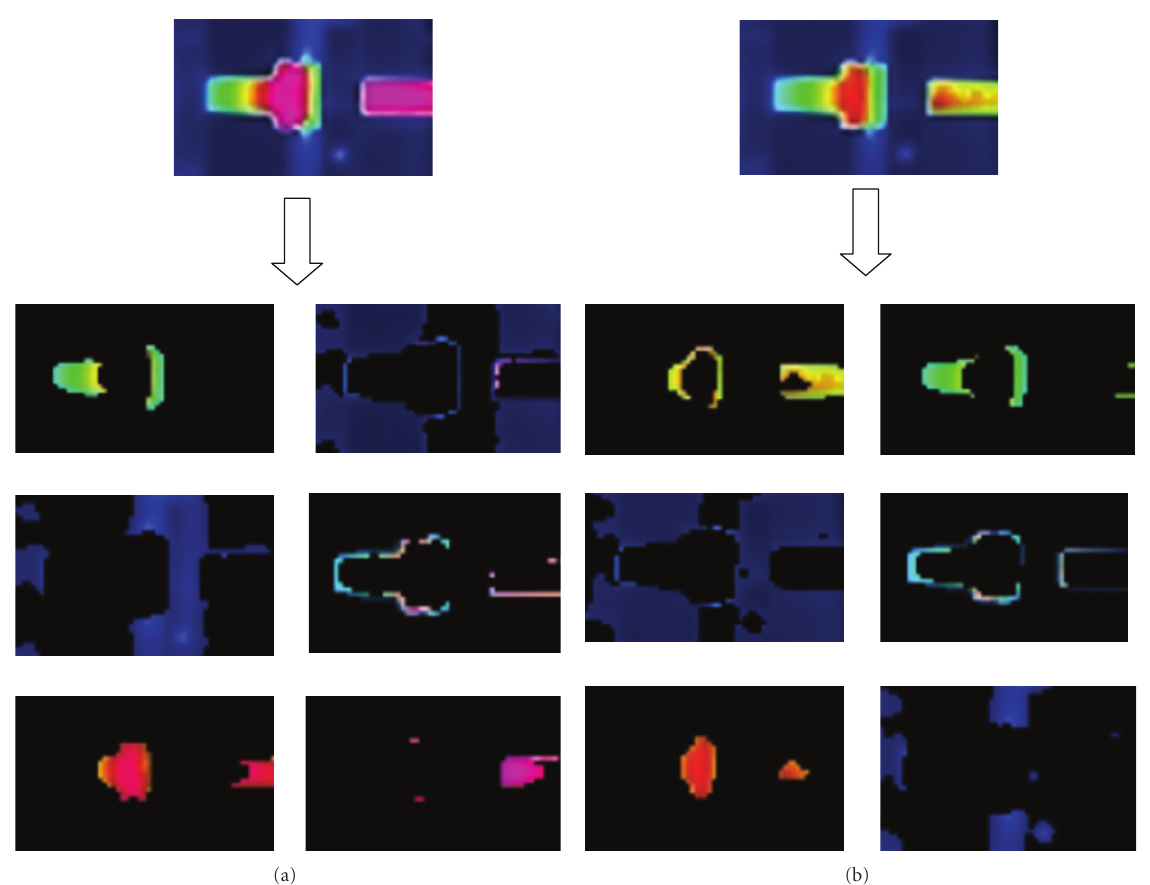
Figure 9: Clustering of bearing images: (a) normal bearing; (b) faulty bearing.